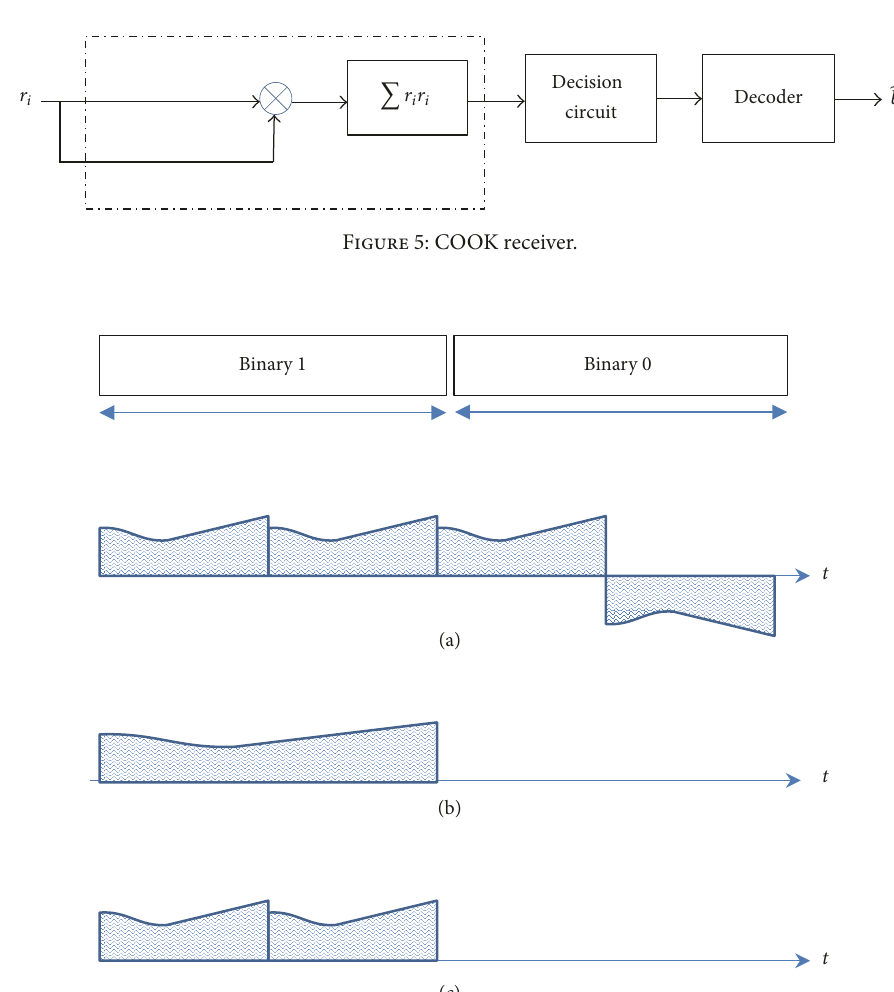
Figure 6: Signal format for chaos based systems. (a) Differentially coherent schemes (CDSK and DCSK). (b) COOK scheme. (c) Proposed scheme